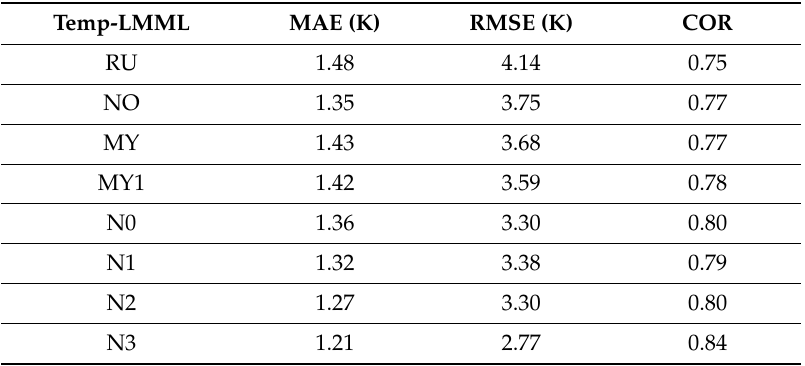
Table A8. Mean absolute error (MAE), root mean square error (RMSE), and correlation coe ffi cient (COR) for surface temperature (Temp) at Luqa (Malta); meteorological aviation reporting (METAR) station code = LMML.